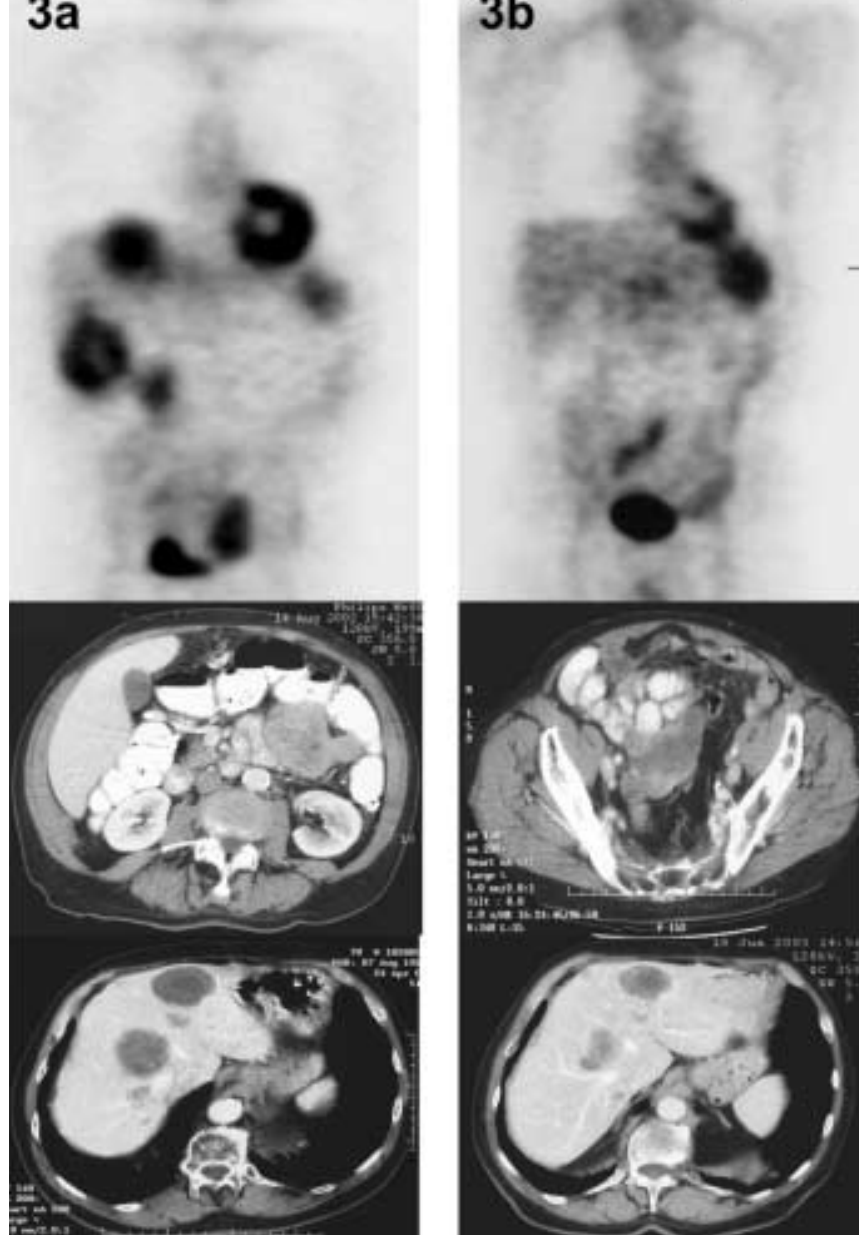
Figure 3 Imaging of